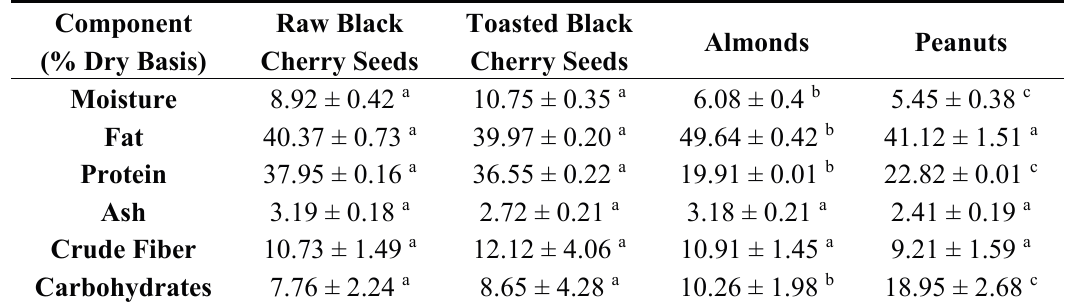
Table 1. Proximate composition of raw and toasted black cherry seeds, almond, and